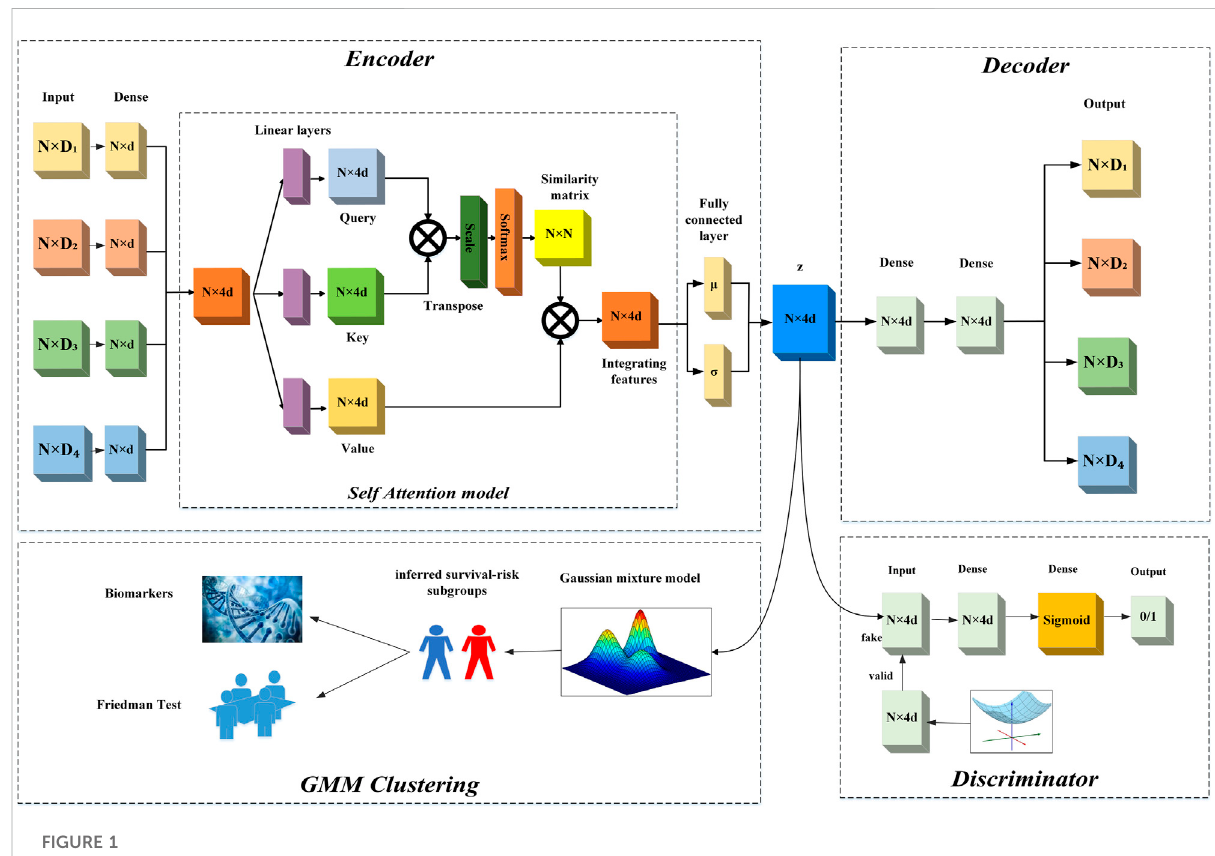
FIGURE 1 The overview architecture of